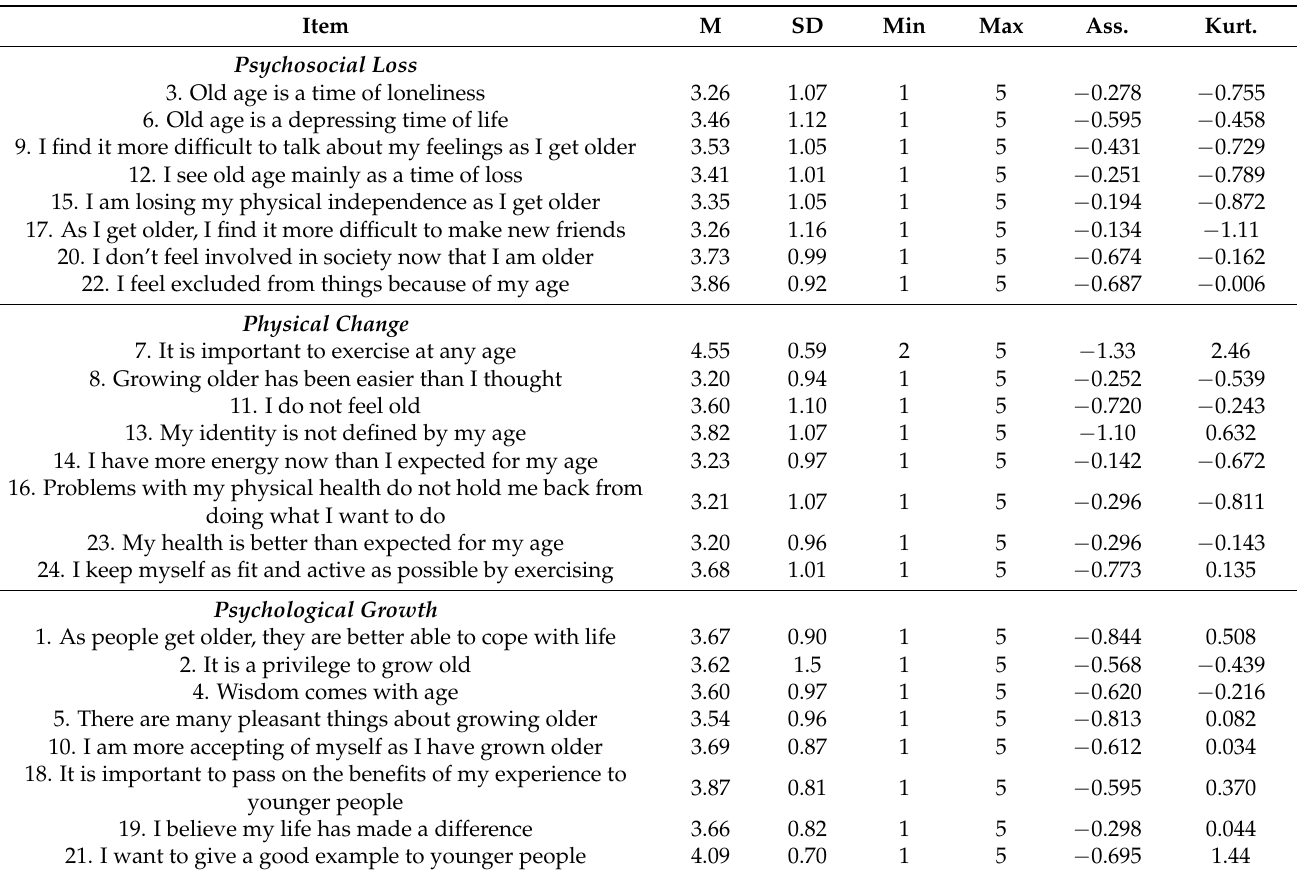
Table 2. Descriptive statistics of the 3-factors,